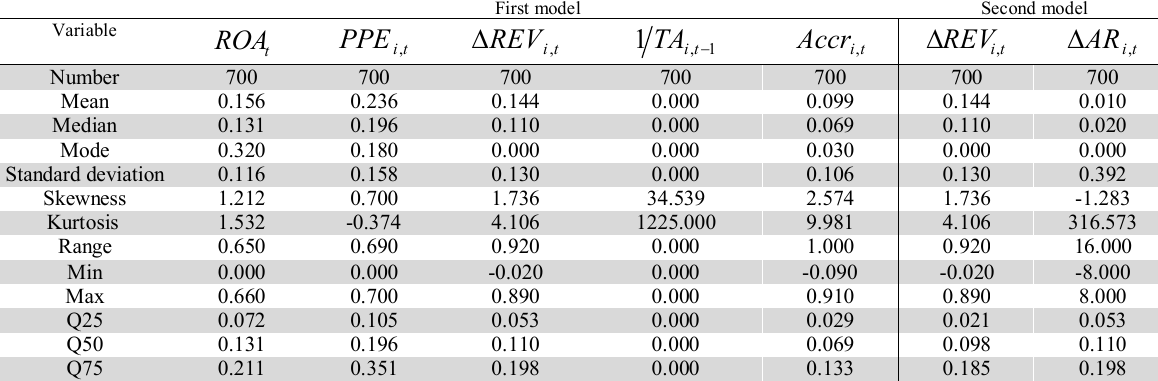
The summary of some basic statistics for the first model